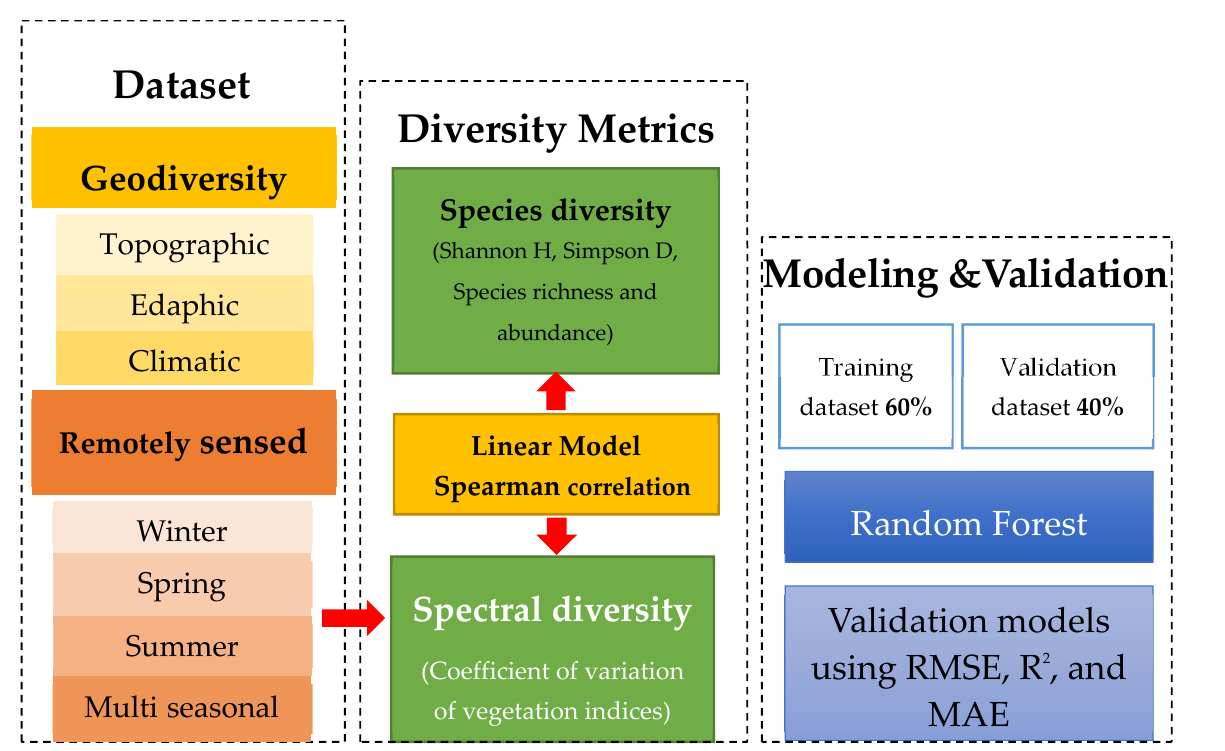
Figure 2. Datasets, metrics, and methodological steps used in this study. Table 1. List of the spectral and geodiversity indices used in this study. Sentinel‑2